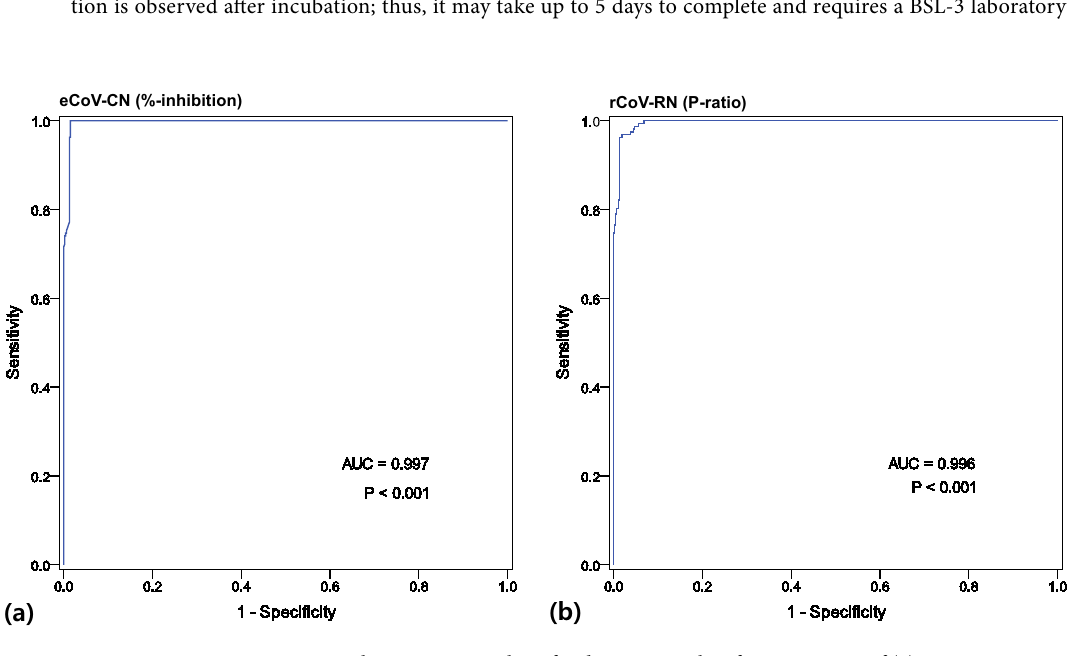
Figure 1. Receiver-Operating Characteristic analysis for detecting NAbs of SARS-CoV-2 of ( a ) VERI-Q SARS- CoV-2 Neutralizing Antibody Detection ELISA Kit (eCoV-CN) and ( b ) VERI-Q SARS-CoV-2 Neutralizing Antibody Rapid Test Kit (rCoV-RN). The optimal cut-off values for %-inhibition of eCoV-CN and P ratio of rCoV-RN obtained from the analysis were 30% and 0.83,